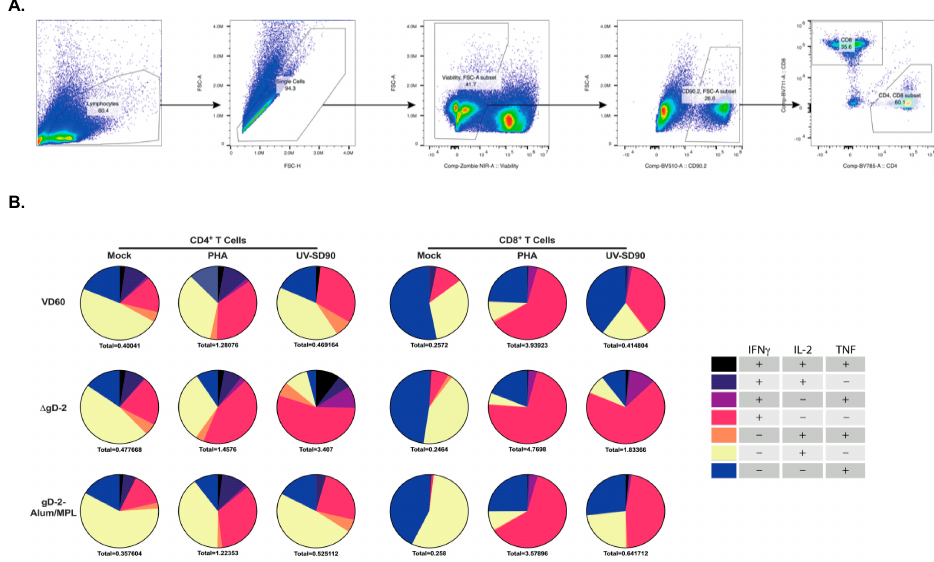
Figure 5. ∆ gD-2 vaccination induces polyfunctional CD4 and CD8 T cells that produce IFN- γ , TNF and IL-2 in response to HSV-2 stimulation. Female C57BL / 6 mice were vaccinated im twice, three weeks apart, with 5 × 10 5 pfu / mouse of ∆ gD-2 and 5 µ g gD-2-Alum / MPL. Splenocytes from vaccinated mice were collected two weeks following boost vaccination and stimulated with PHA or UV-inactivated HSV-2 (SD90) for 18 h with Brefeldin A treatment before staining and flow cytometric analysis for the production of IFN- γ , TNF and IL-2. The gating strategy is shown in ( A ), and cytokine responses for CD4 and CD8 T cells in ( B ). Pie charts represent the population producing at least one cytokine. Total cytokine-producing cells as a percentage of live CD4 and CD8 T cells is indicated below each graph; n = 5 mice per group. Vaccines 2020 , 8 , x